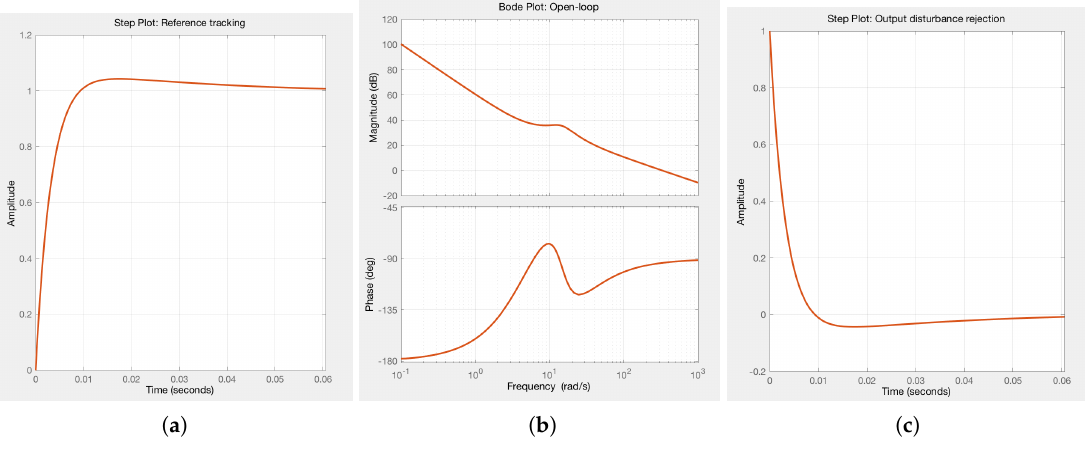
Figure 11. Performance of 2DOF control. ( a ) step response of traditional 2DOF control; ( b ) Bode diagram of traditional 2DOF control; ( c ) output disturbance rejection of a traditional 2DOF